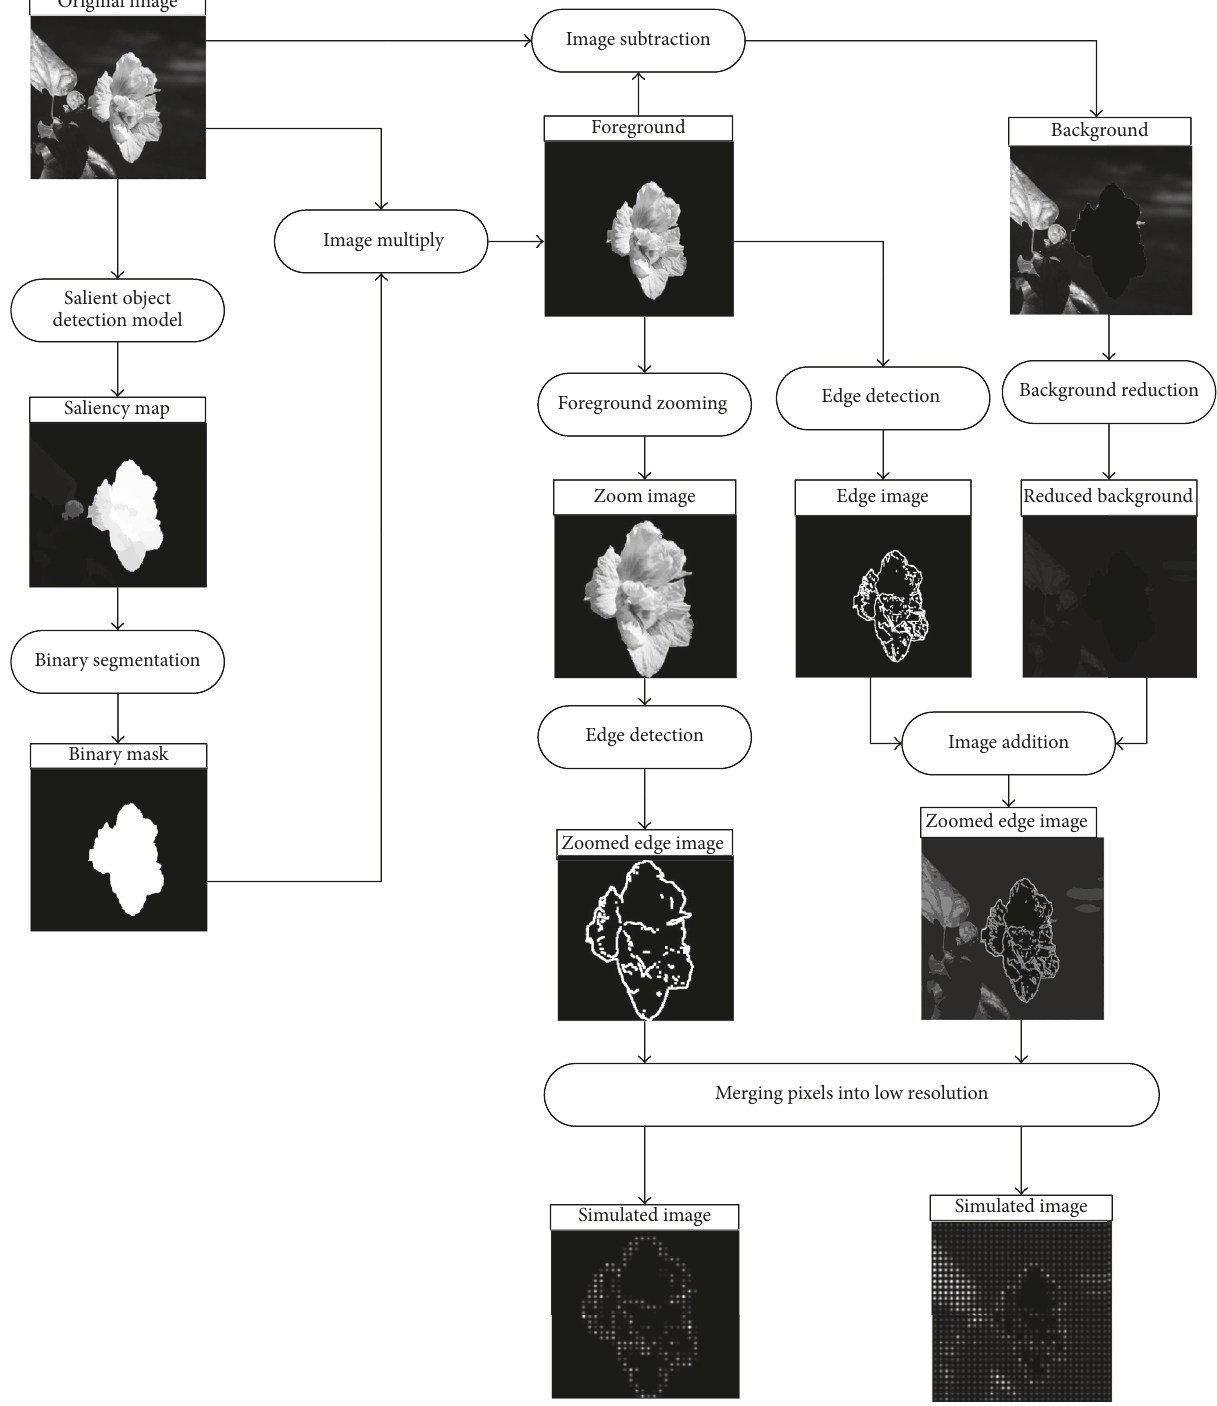
Figure 1: Schematic diagram of the two image processing